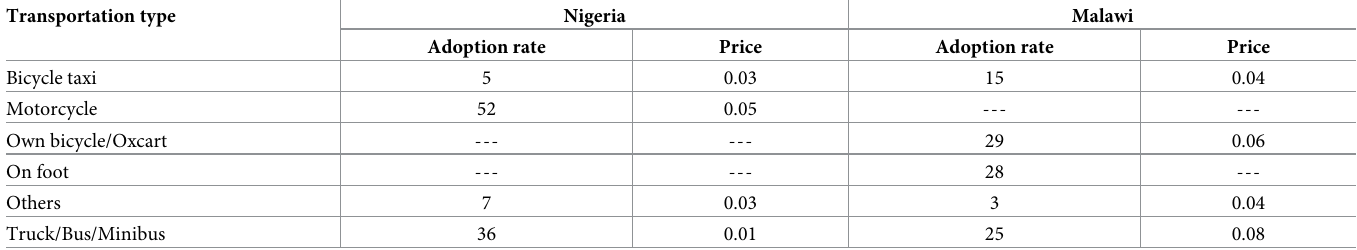
Table 4. Transportation type utilized by farmers to reach markets and purchase fertilizer, adoption rate (%), and median price paid (USD kg -1 of purchased fertil- izer) reported by LSMS for Nigeria and Malawi. Transportation